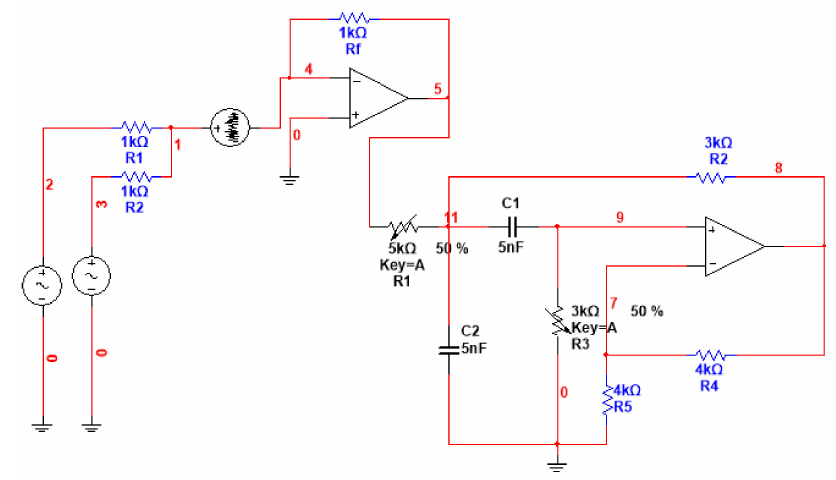
Figure 3. Sallen − Key band‑pass filter